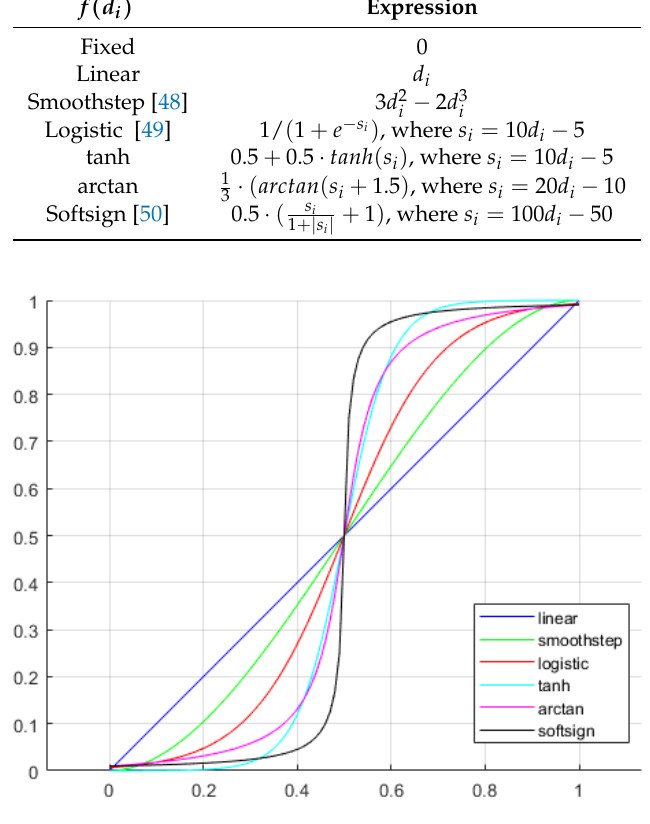
Figure 8. Superposition of the different tested expressions, with values of d i mapped into the range [ 0,1 ]